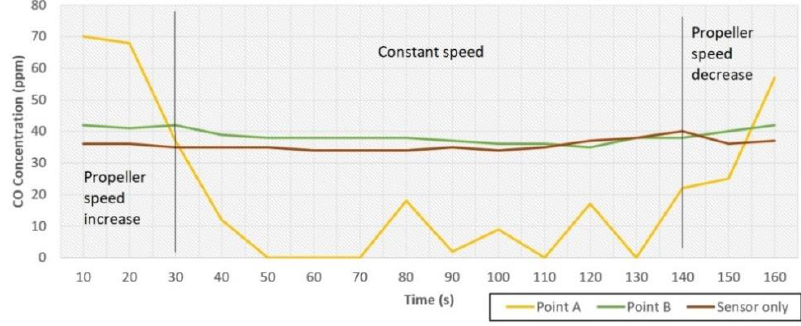
Figure 5. Comparison of sensor positions.